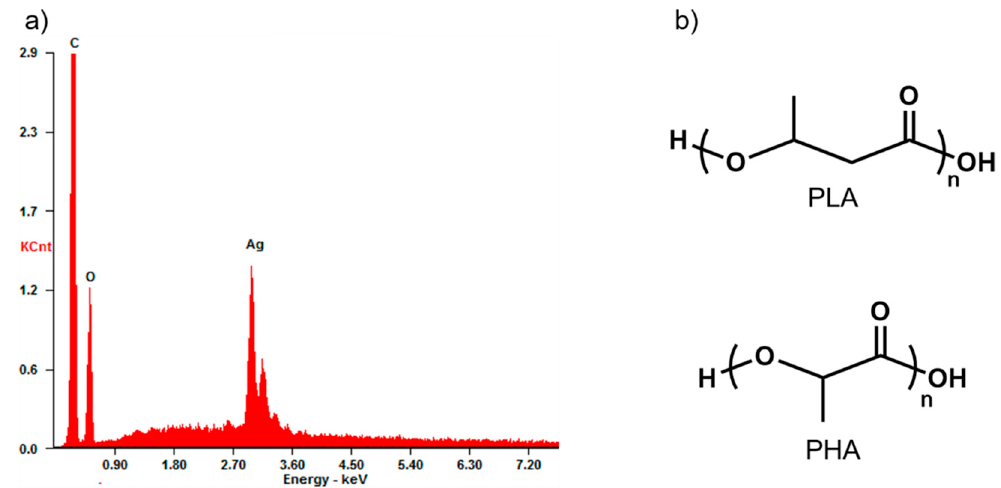
Figure 4. (a ) EDX spectrum of PLA/PHA+AgNP; ( b ) chemical structure of PLA and PHA.